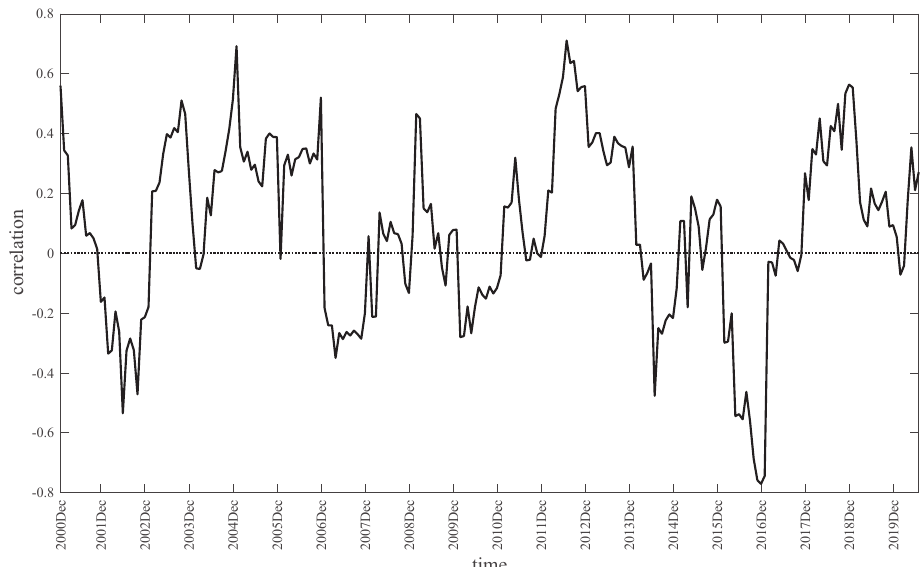
Figure 1. Correlation between housing capital return and SSEC